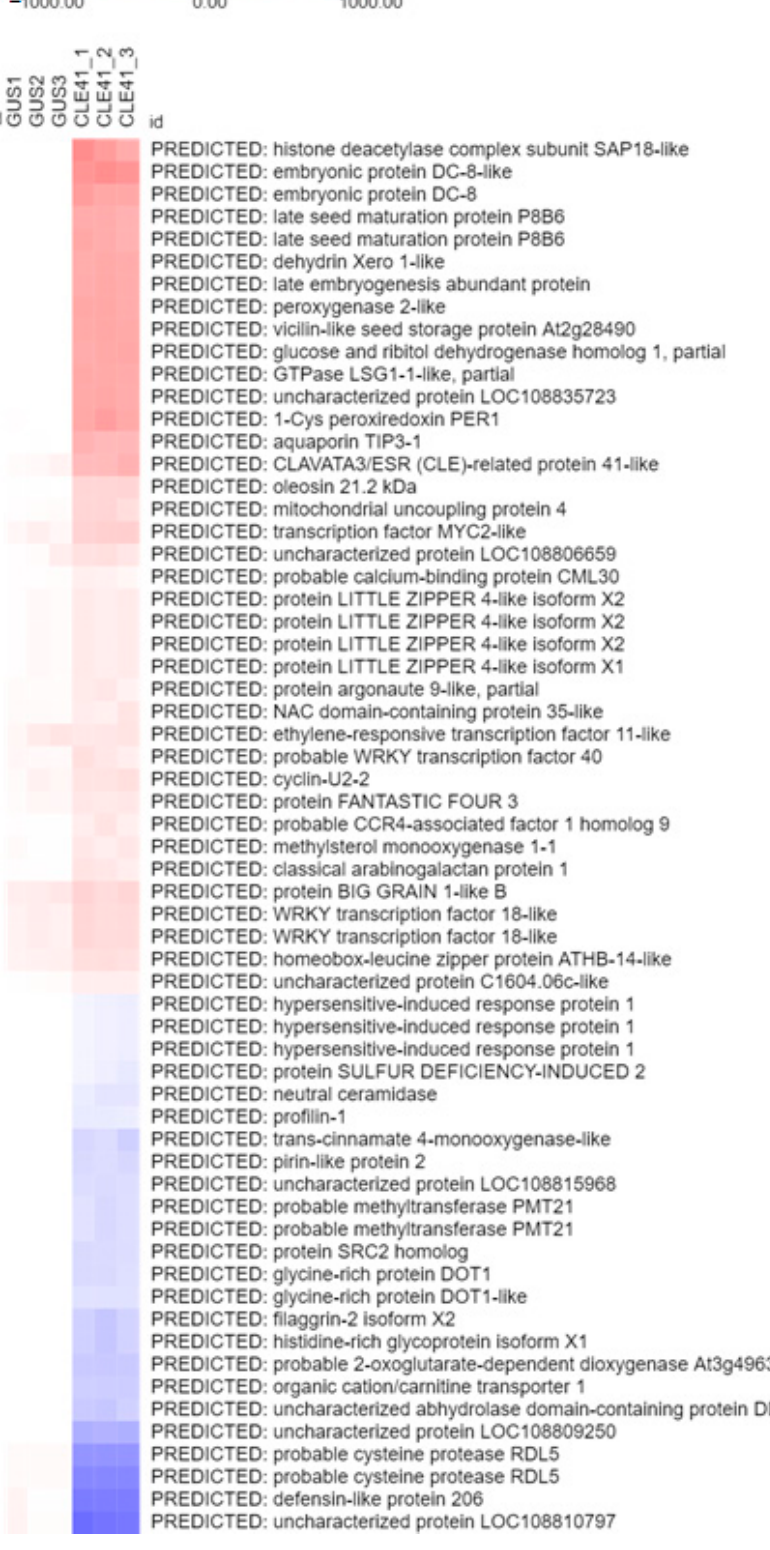
Figure 1. Heatmap representing expression levels of genes which were differentially expressed in the 35S:RsCLE41-1 roots in comparison to the 35S:GUS roots of